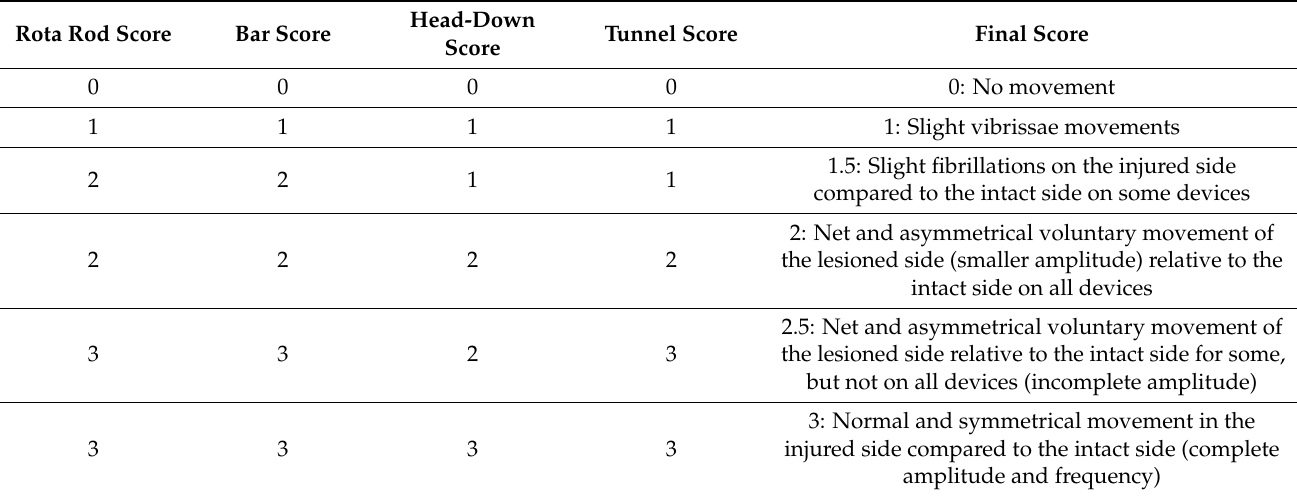
Table 2. Videoscoring of whisker movement recovery.